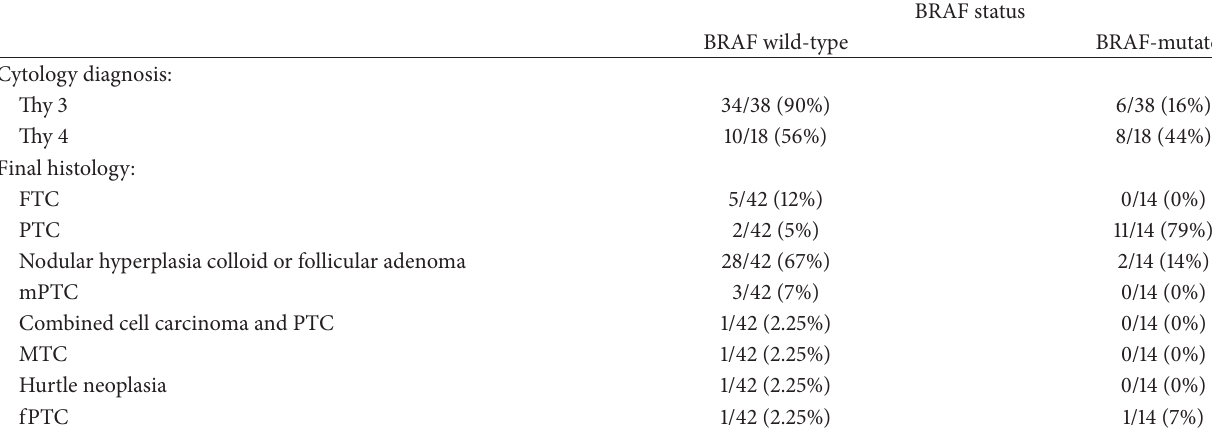
Table 2: Correlation of BRAF status and clinicopathological